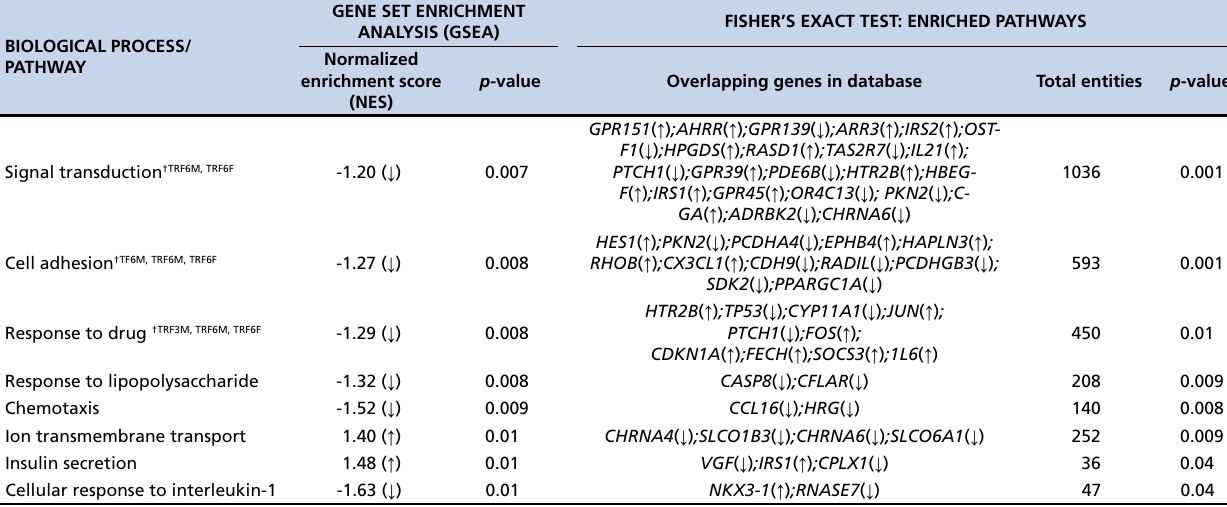
Supplementary Table 4 - List of biological processes significantly modulated in female subjects after 6 months of α -TF